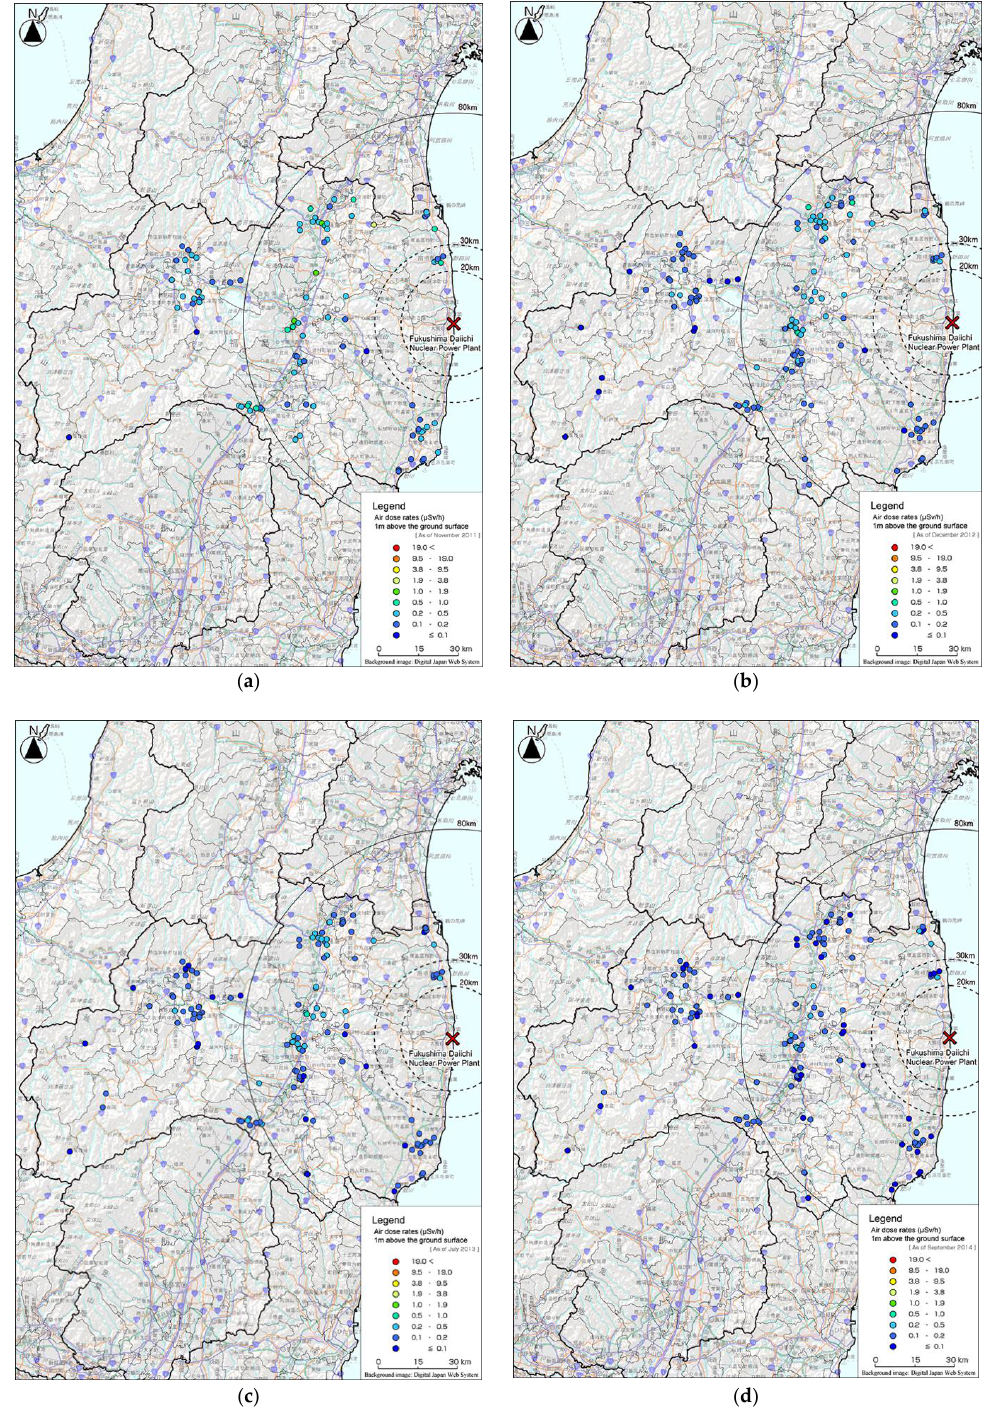
Figure 4. Results of radiation monitoring for child care facilities in Fukushima Prefecture as of ( a ) November 2011; ( b ) December 2012; ( c ) July 2013; ( d ) September 2014 (in µSv/h) [63].